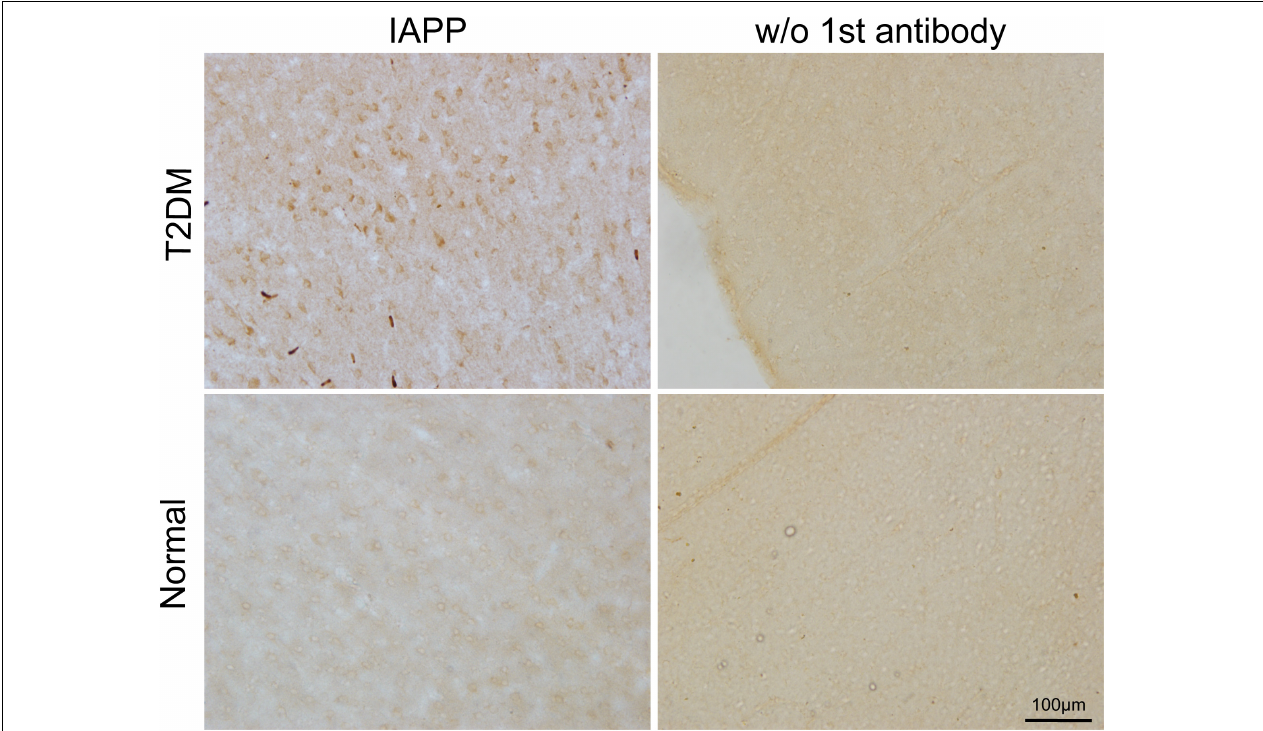
FIGURE 4 | IAPP in the motor cortex of a diabetic and a normal monkey. Immunohistochemistry for IAPP in the motor cortex and corresponding negative control ( right panel , incubation without the IAPP primary antibody) from a T2DM monkey (upper panels) (ID:DM940790) and an age-matched normal monkey (lower panel) (ID:N942303). Scale bar = 100 µ